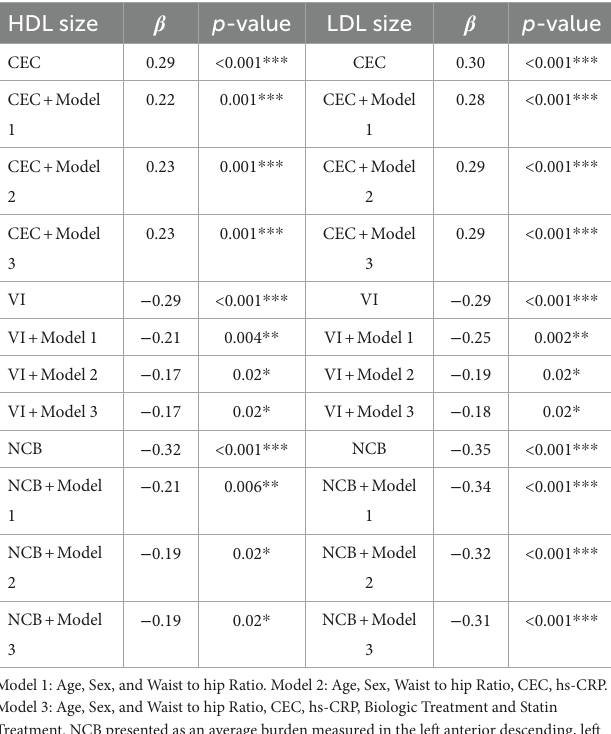
TABLE 3 High density lipoprotein size regression analysis with CEC, VI, and